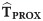
Comparison between the reference TPROX (grey line) and its reconstruction T^PROX (black line) obtained in one subject with three sensors (A, RIA, RMT) worn for 22.5 hours, weighed by the appropriate coefficients provided in Table 1.The gaps in the plot are the result of the pre-processing procedure described in S1 File.